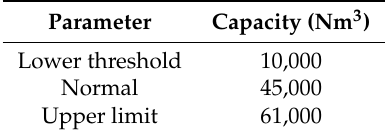
Table 3. LDG gasholder capacity parameters.